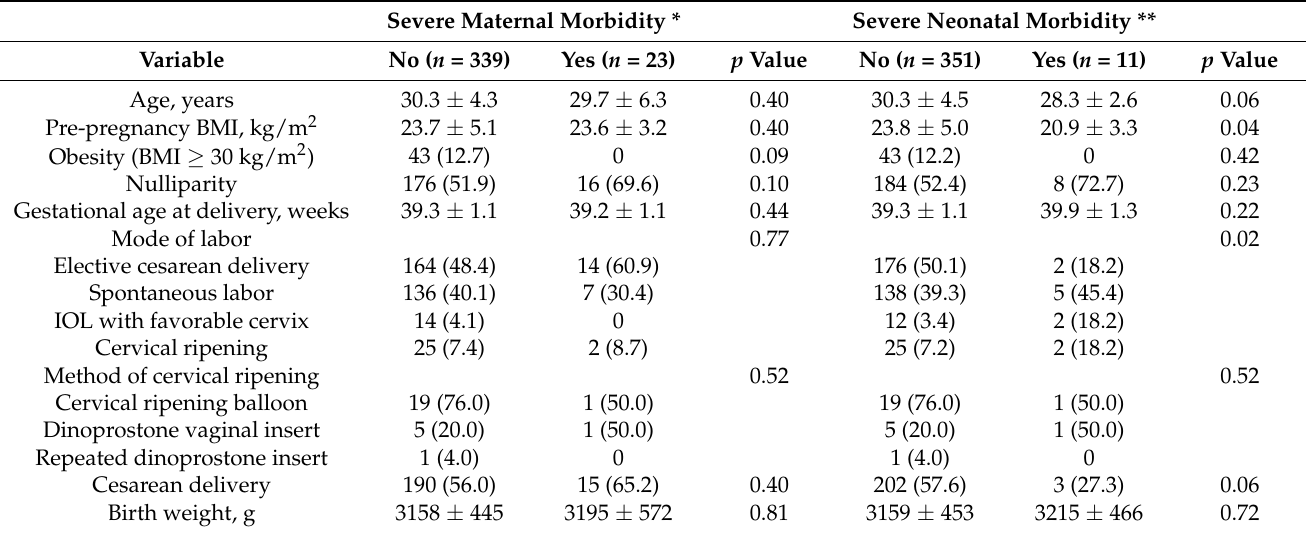
Table 4. Univariate analysis of severe maternal and neonatal morbidity after planned cesarean delivery or spontaneous or induced labor.